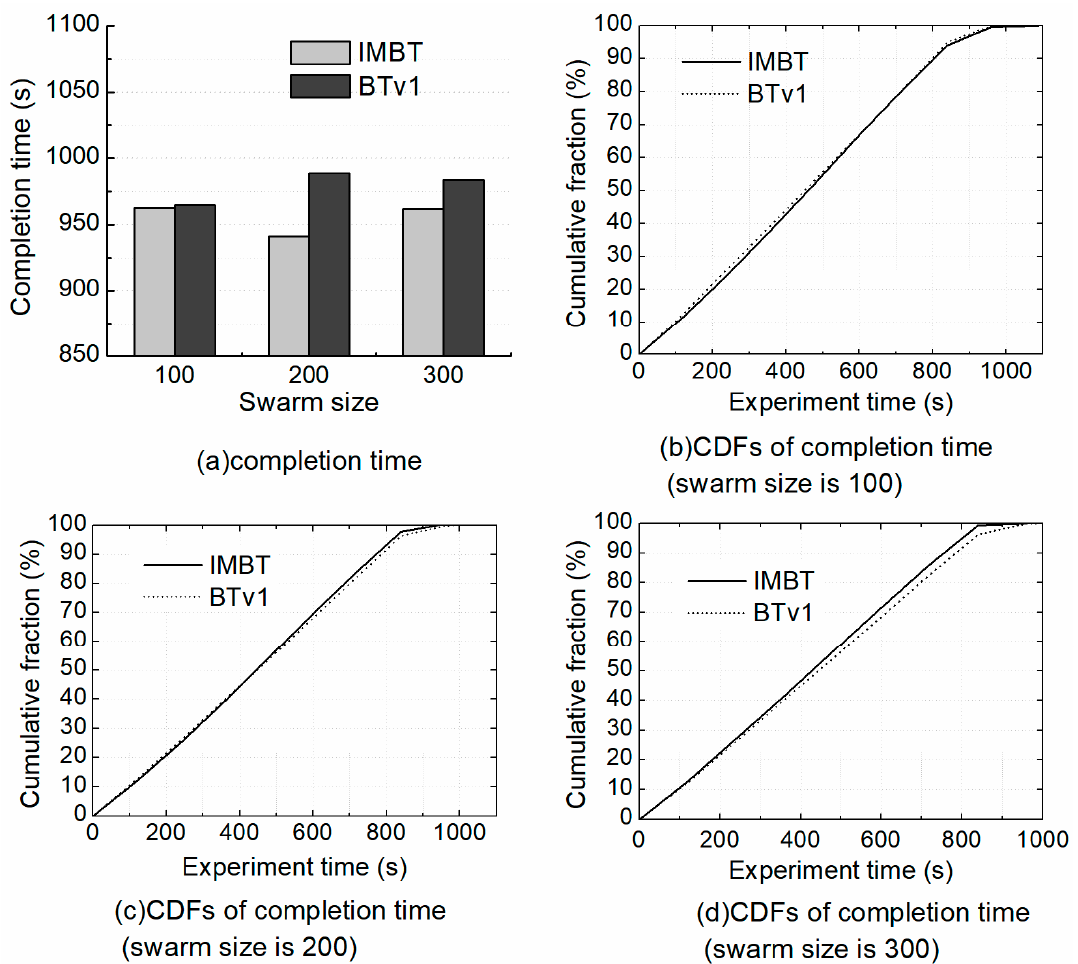
Figure 7. Download Completion Time under Different BT Group of Germany50, ( a ) is completion time comparision of IMBT and BTv1 under different swarm size, ( b ), ( c ), ( d ) is the detail downloading process of cumulative fraction under different swarm size of IMBT and BTv1.